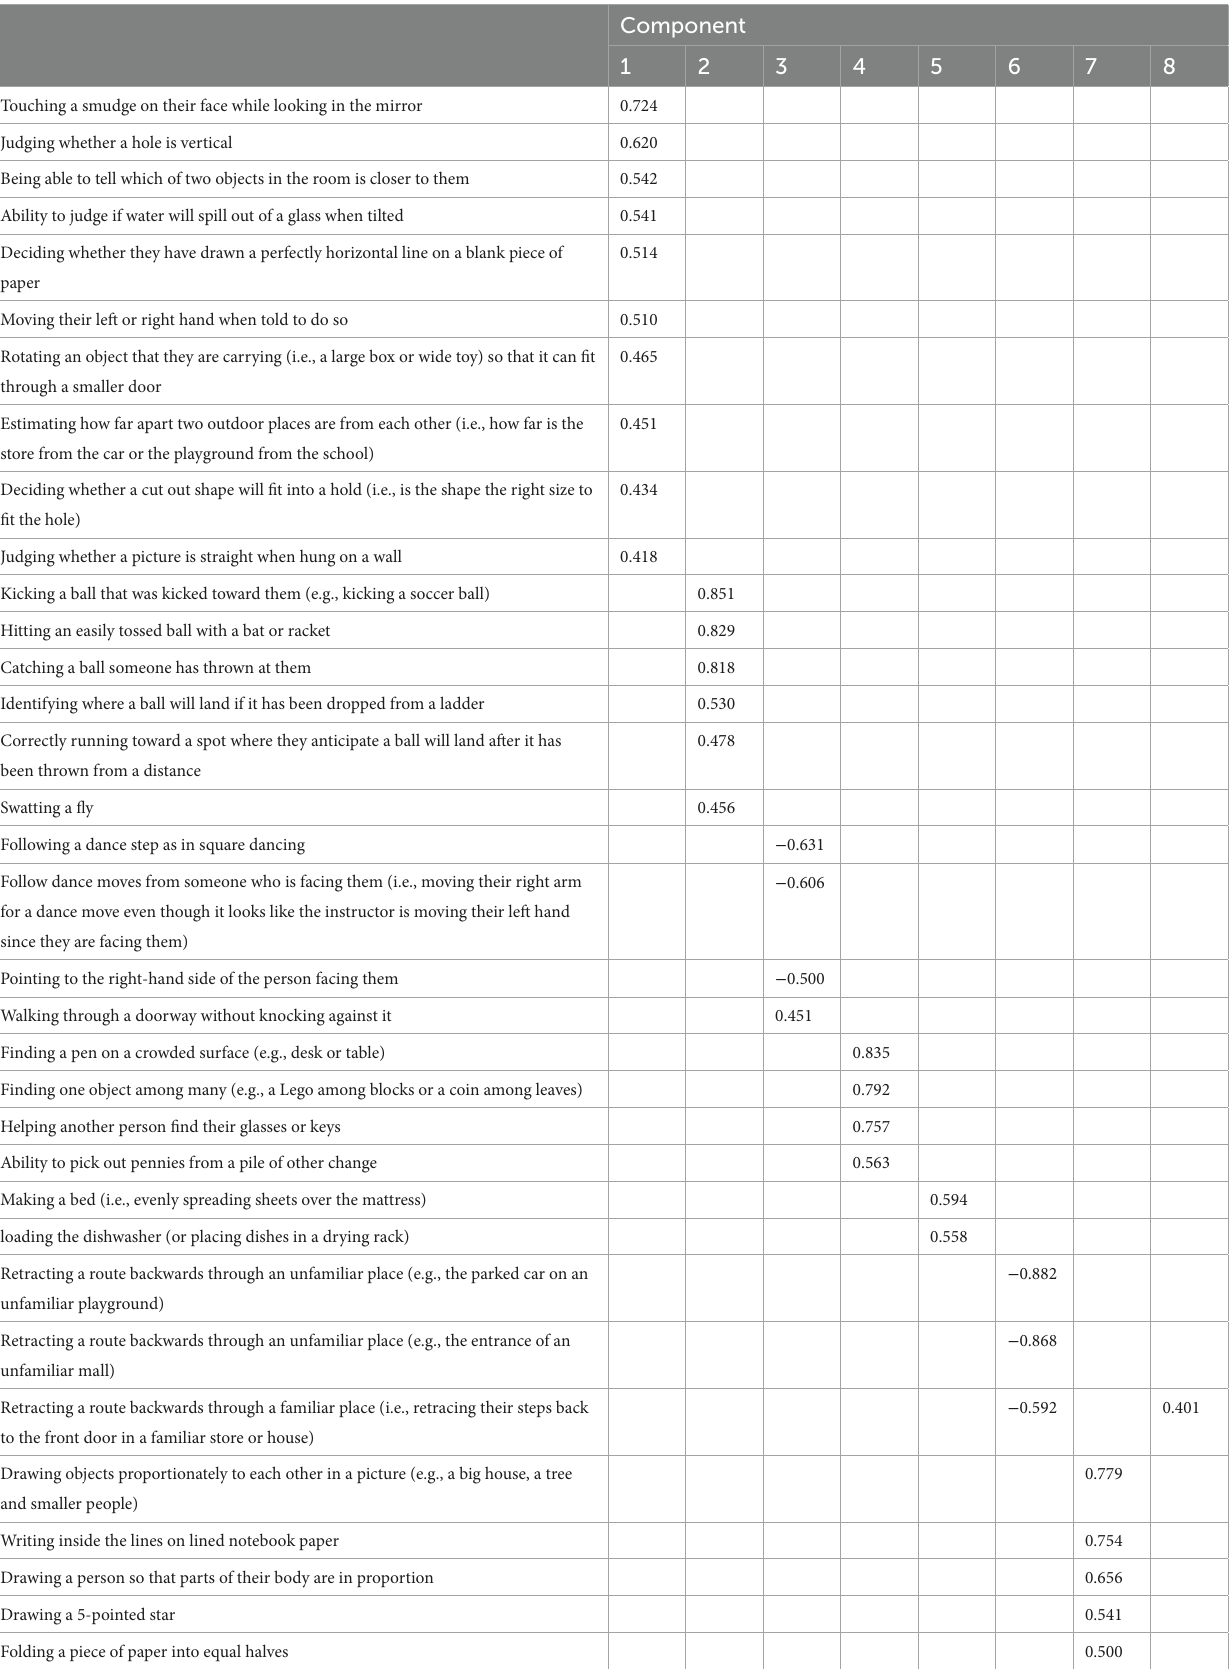
TABLE 2 Pattern matrix based on the principal component analysis.